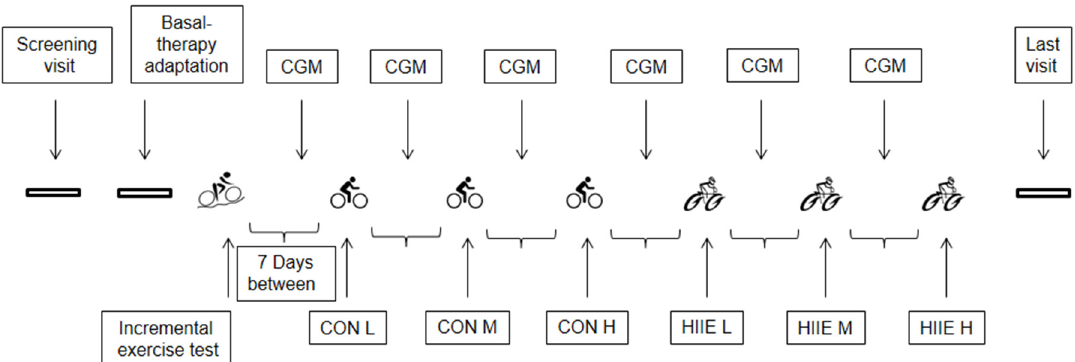
Figure 1. Timeline chart of the study. CGM = continuous glucose monitoring, CON = continuous exercise, HIIE = short high-intensity interval exercise. CON/HIIE L, M, H = low intensity, moderate intensity, high intensity CON/HIIE.